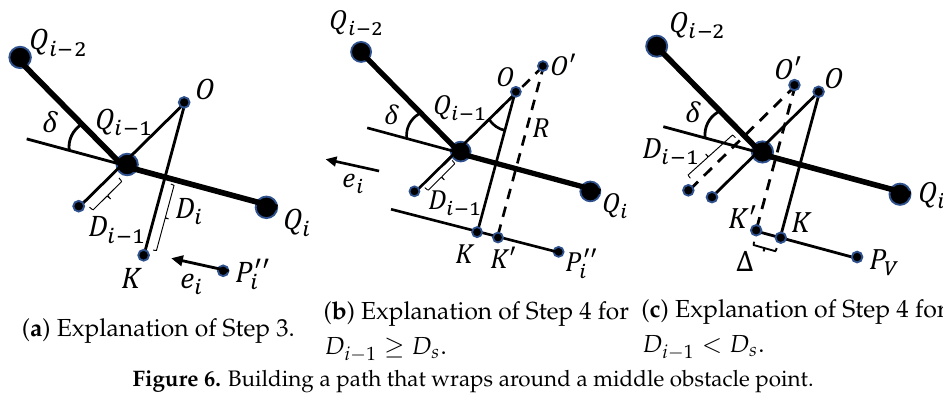
Figure 6. Building a path that wraps around a middle obstacle